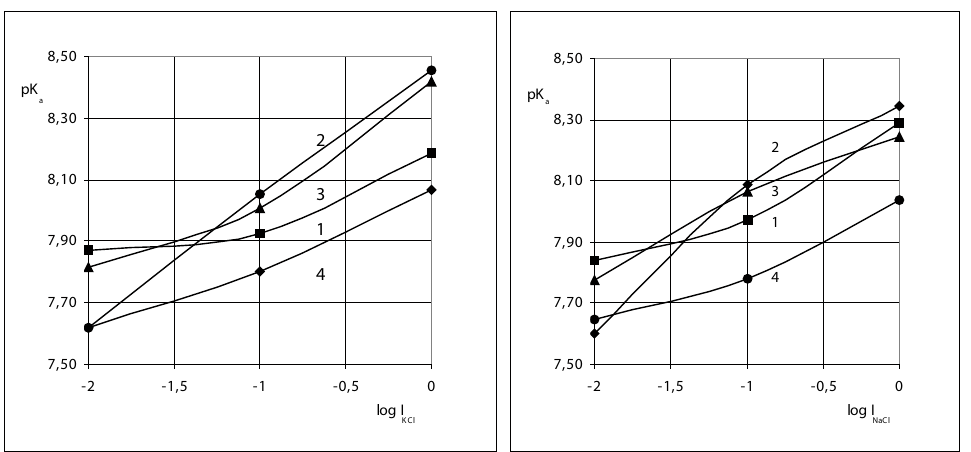
, 3 – 10 mmol L -1 H 3 of sanguinarine R+